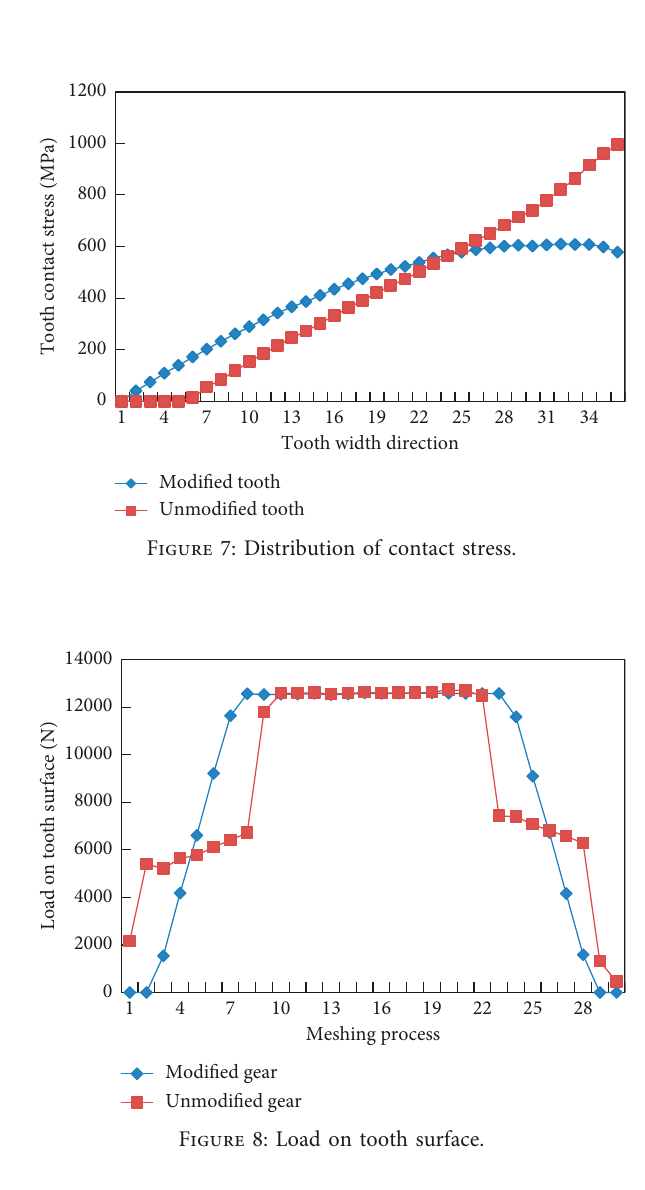
Figure 6: Contour map of contact stress. (a) Without modification. (b) Comprehensive modification.